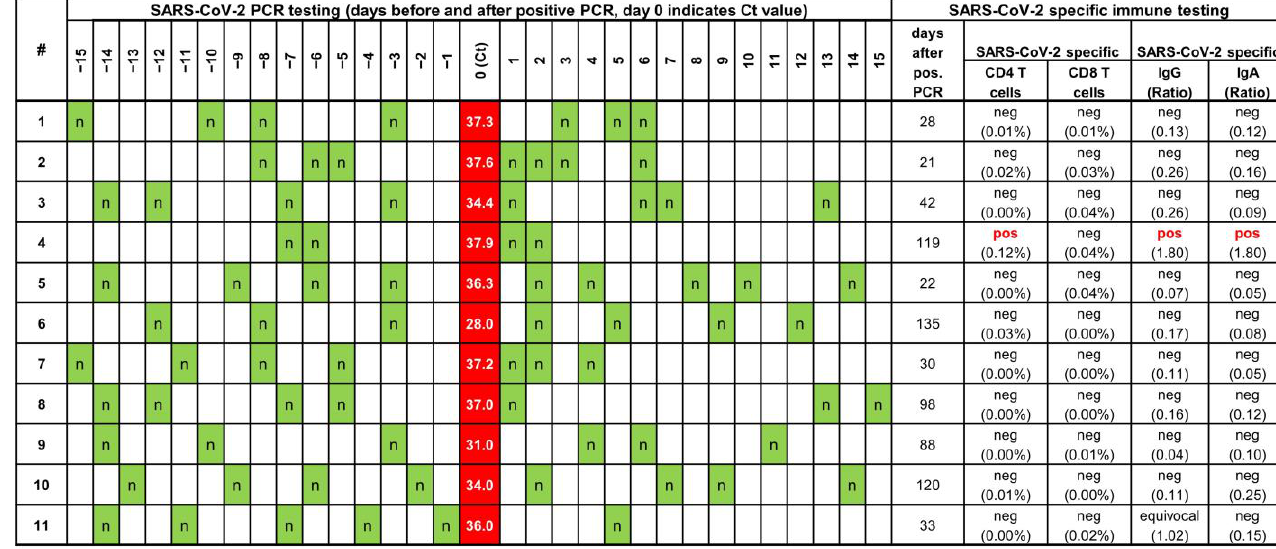
Figure 1. Overview of SARS-CoV-2 PCR test results over time and SARS-CoV-2 specific humoral and cellular immune response. Each line shows data from one individual. The chronological order of PCR testing before and after the positive test is shown with the positive PCR test result including Ct value labeled in red, and negative PCR results in green and indicated by an “ n ”. SARS-CoV-2 specific IgG and IgA were determined at a median of 42 (range 21–114) days after the positive PCR test. Individual #4 had negative serological results on screening 3 and 4 months before the positive PCR test, individual #11 had negative serological results on screening 6 months before the positive PCR. Ct, cycle threshold; IQR, interquartile range; PCR, polymerase chain reaction.